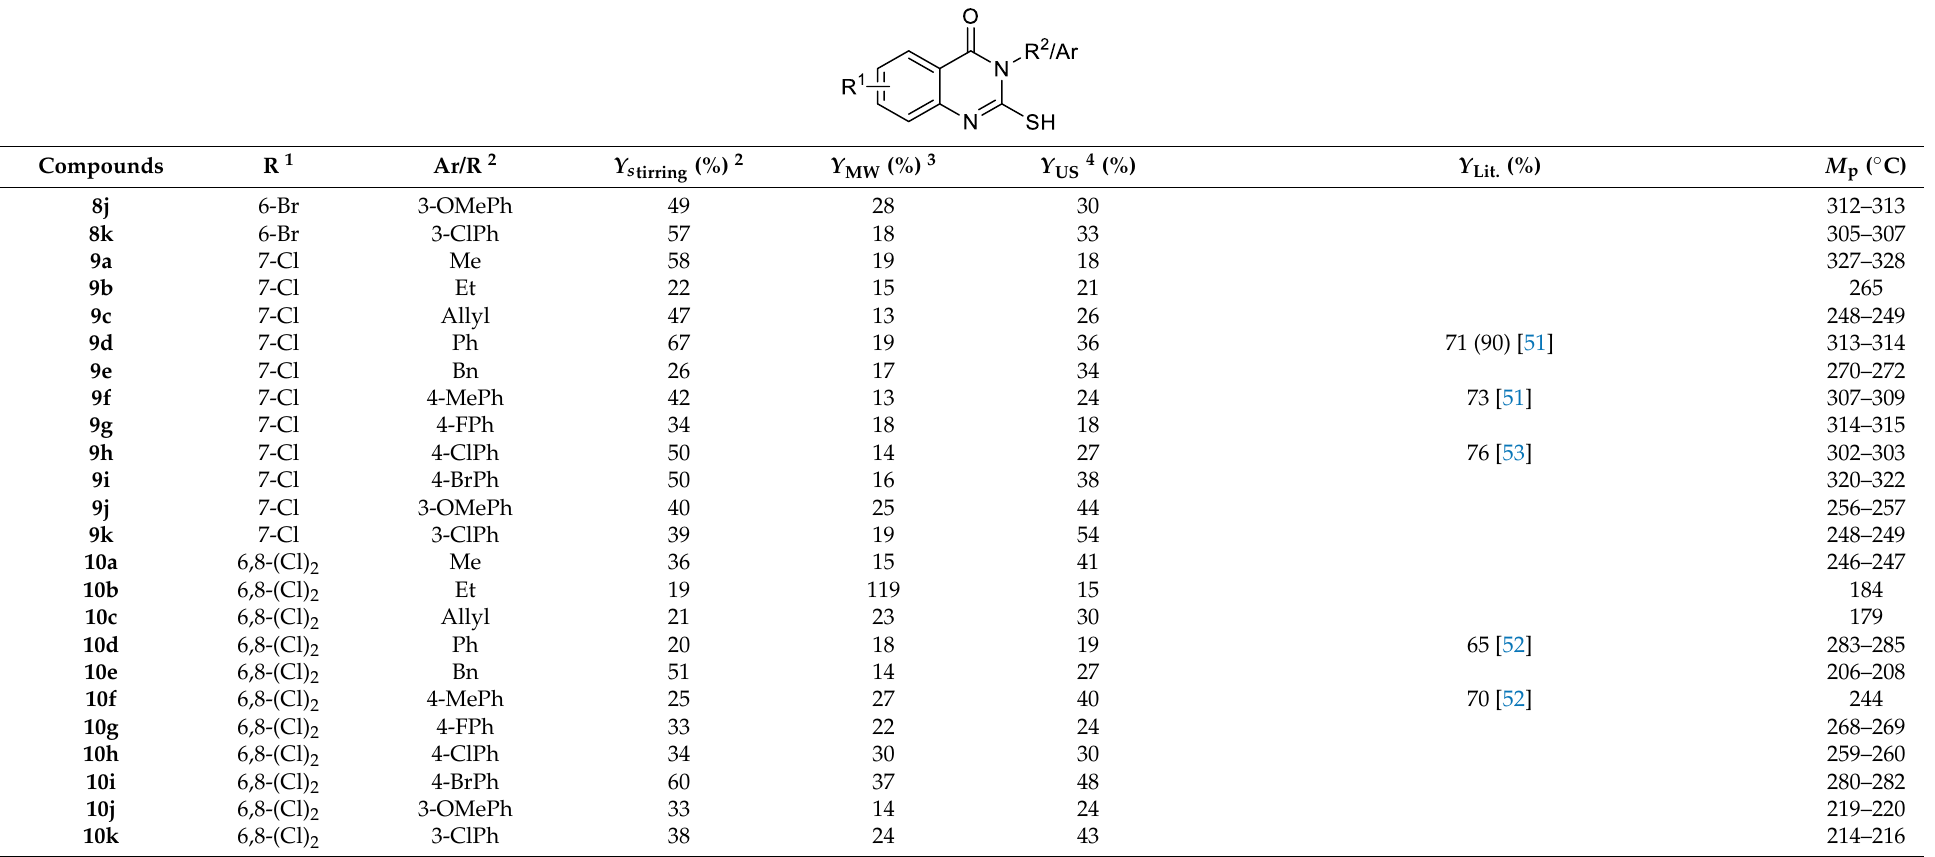
Table 2. A comparison of the substituted 2-mercaptoquinazolin-4(3 H )-ones yields 1 obtained with Table 2. Cont . selected green methods with literature